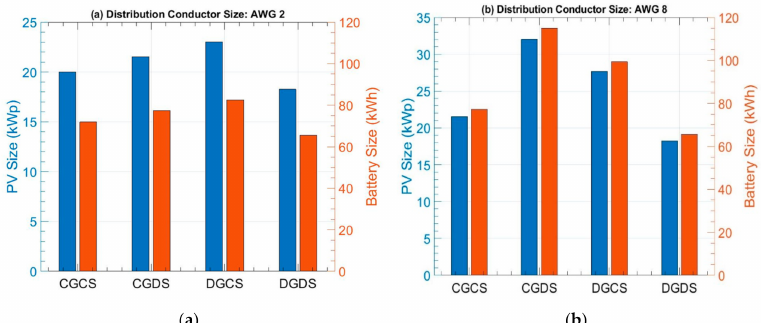
Figure13. ( a )PVsizing(lefty-axis)andbatterysizing(righty-axis)comparisonamongfourarchitectures with AWG 2 conductor ( b ) PV sizing (left y-axis) and battery sizing (right y-axis) comparison among four architectures with AWG 8 conductor.